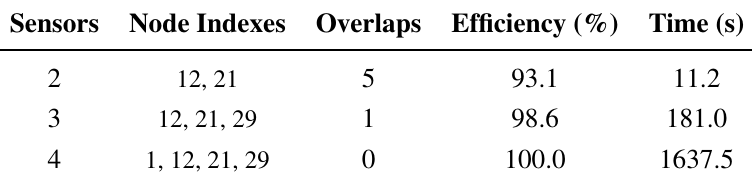
Table 1. Sensor placement in the Hanoi network using the semi-exhaustive